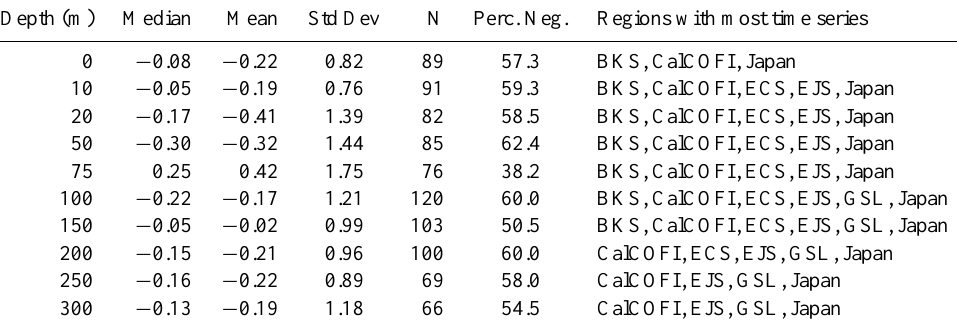
Table 6. Oxygen trend statistics (µmolL − 1 yr − 1 ) calculated from raw data in the transition band, between 30 and 100km from the shoreline, for the 1976–2000 period. Abbreviations: C. I. = confidence interval; Std Dev = standard deviation; N = number of time series; Perc Neg = Percentage of negative trends. Region abbreviations: BKS = Baltic Sea, Kattegat and Skagerrak; CalCOFI = California Cooperative